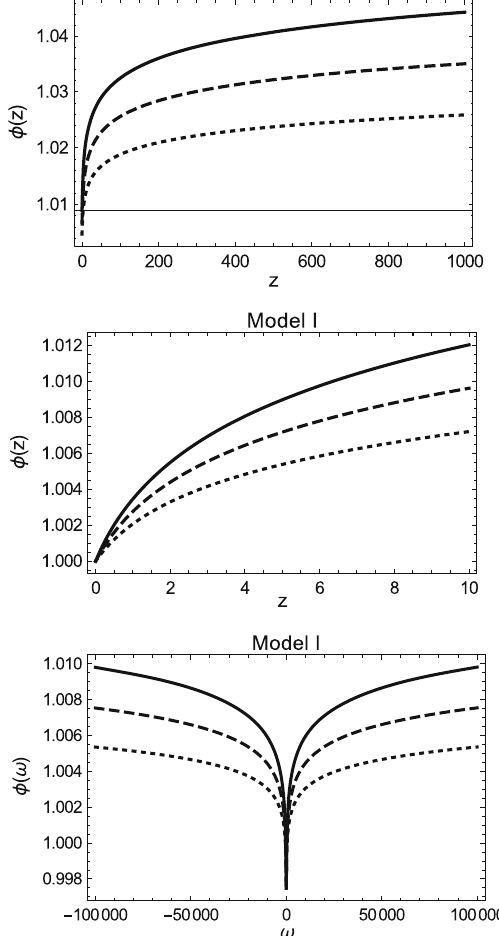
Fig. 1 Plots of the Brans Dicke scalar field φ for Model I using dif- ferent n . The top most figure shows the logarithmic variation of φ as a function of z scaled with φ 0 . The graph in the middle shows the scaled out variation of φ w.r.t. z at low redshifts. The lowermost graph gives the variation of φ as a function of the Brans Dicke parameter, ω . In the figure, n = 650: black, n = 750: black, dashed, n = 1000: black,